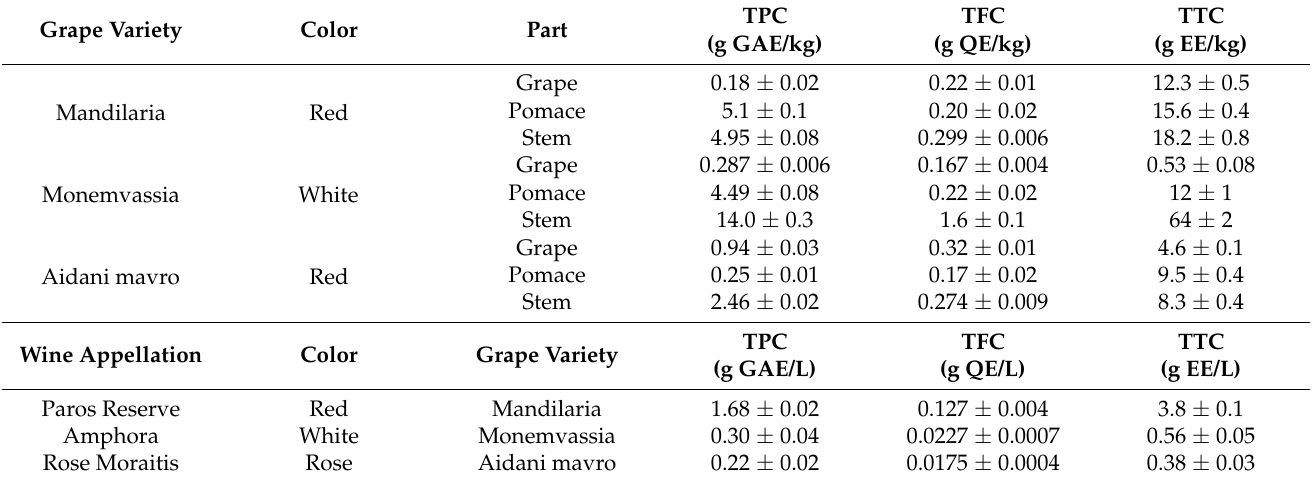
Table 4. Total phenolic (TPC), flavonoid (TFC) and tannin (TTC) contents of samples tested. Grape Variety